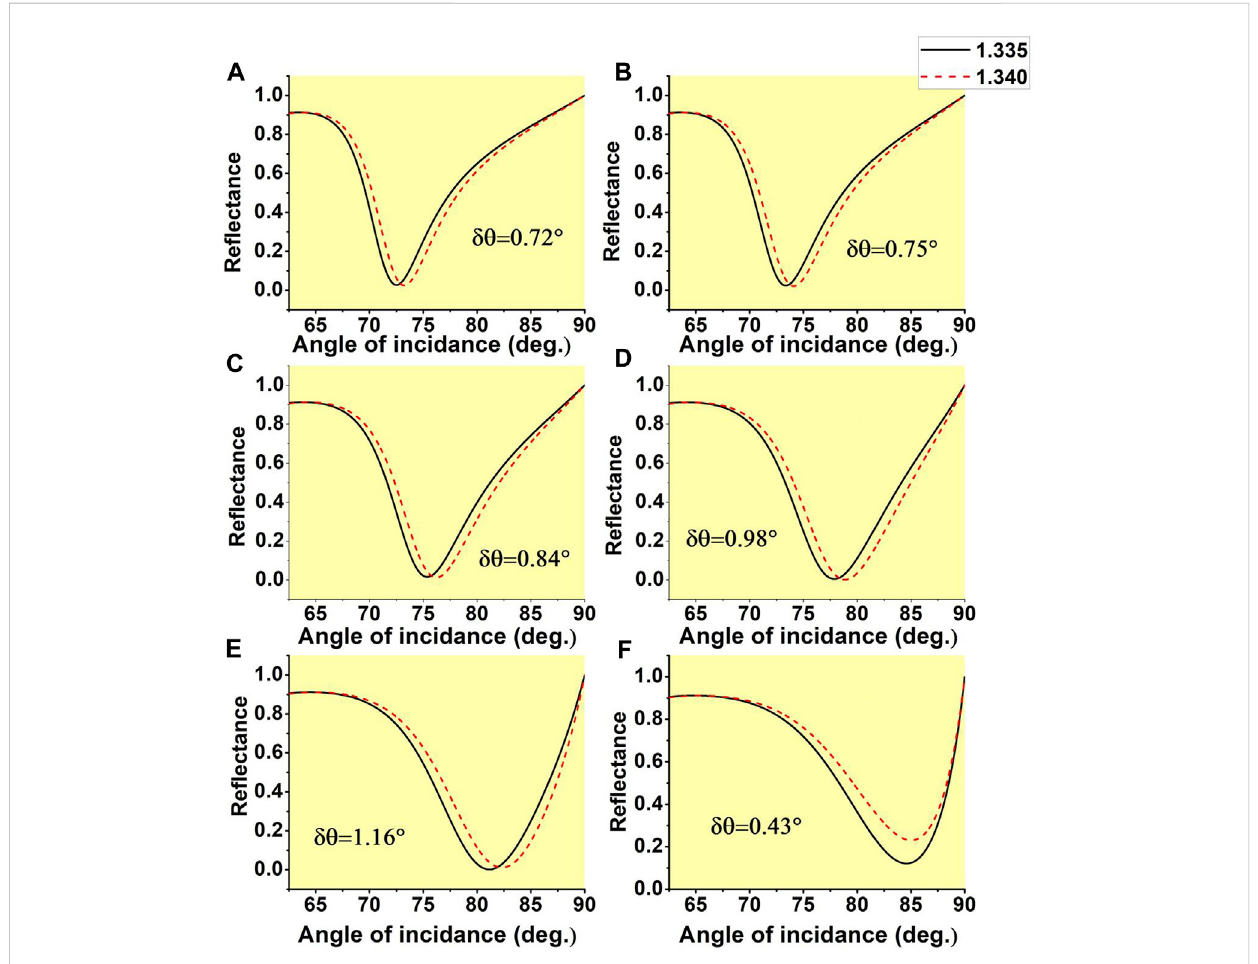
FIGURE 4 The variation of the re fl ectance with the angle of the incidence of the prism for the two RI of the analyte 1.335 and 1.340 when the thickness of the adhesionlayerofMgOisconsideredas5 nm,whilethenumberofBPlayersonAgare (A) 1layer (B) 2layers (C) 4layers (D) 6layers (E) 8layers (F) 10layers.